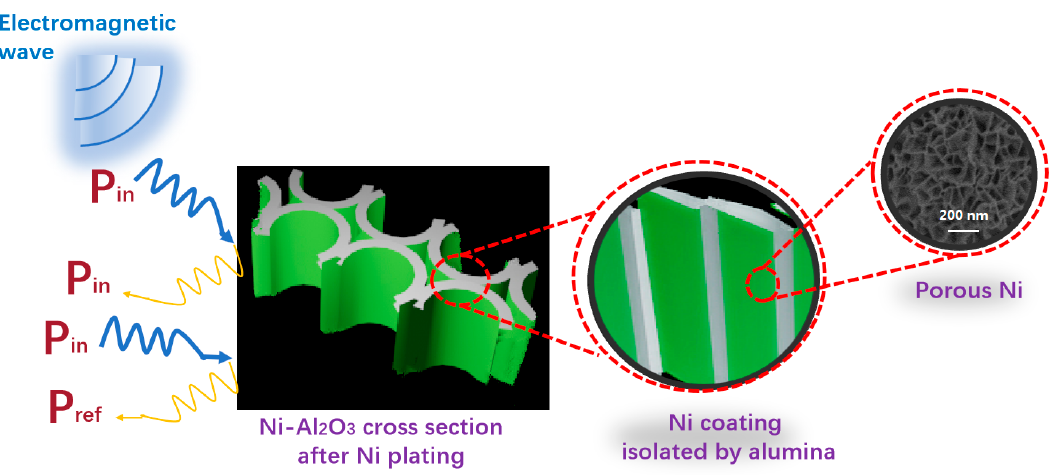
Figure 9. Schematic for the wave absorption mechanisms of Ni / Al 2 O 3 / Ni film cross-section after nickel plating.